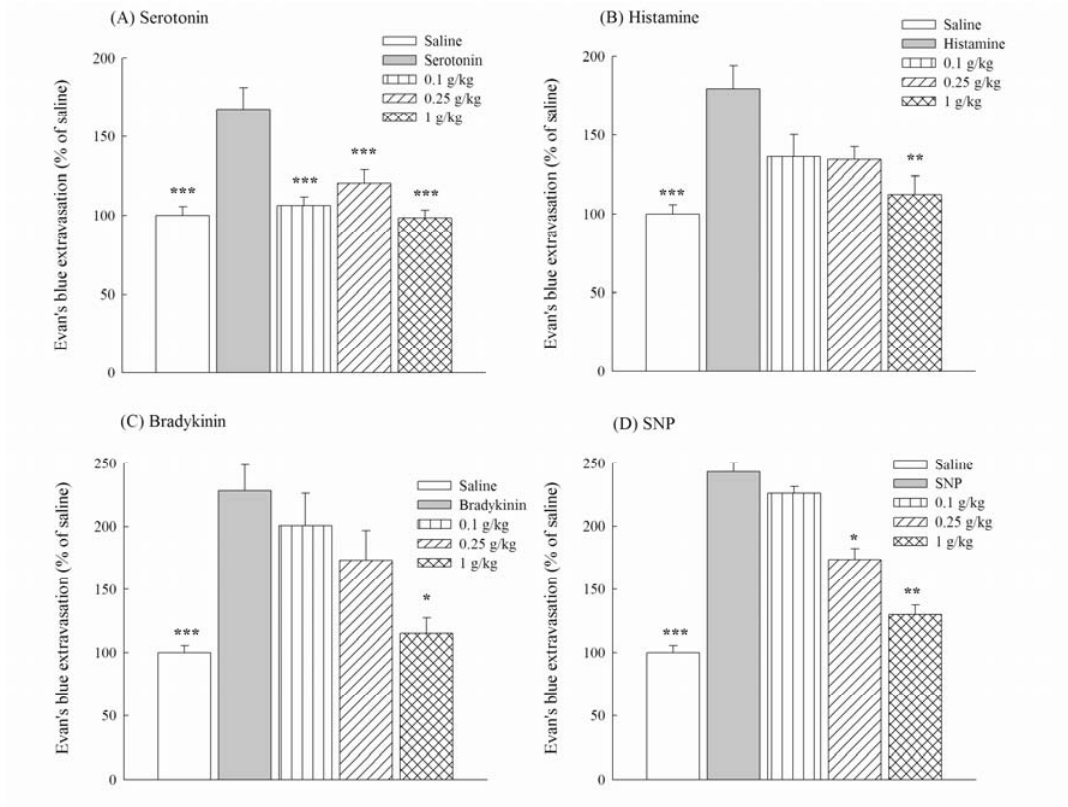
Figure 5. Effects of methanol extracts from Ligustrum pricei (0.1, 0.25, 1 g/kg) on microvascular permeability increased by serotonin (A), histamine (B), bradykinin (C) and SNP (D) in